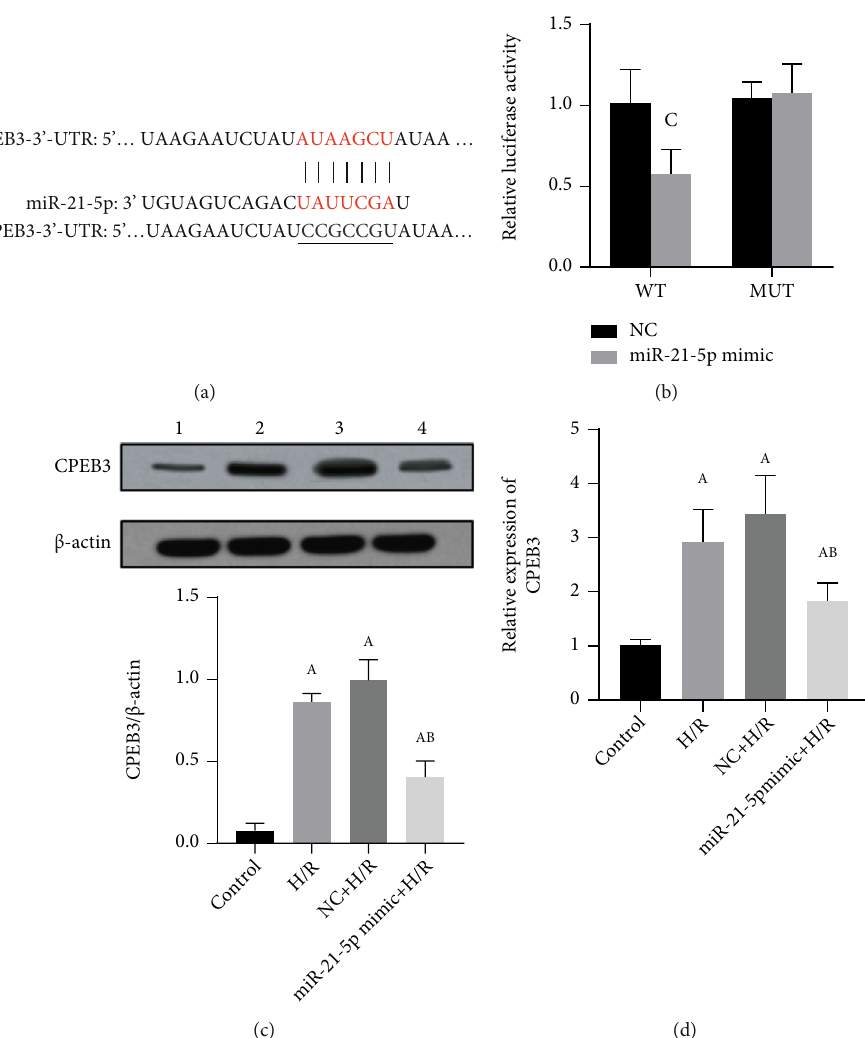
Figure 5: The veri fi cation of CPEB3 as a target of miR-21-5p ( n = 3 ). (a) CPEB3 as the target of miR-21-5p. (b) Luciferase reporter gene veri fi cation. (c) Protein expression level of CPEB3 when miR-21-5p was overexpressed in HT22 cells. (d) The expression level of CPEB3 mRNA when miR-21-5p was overexpressed in HT22 cells. The experimental groups are as follows: 1: control group; 2: H/R group; 3: NC+H/R group; 4: miR-21-5p mimic+H/R group. Note: Student ’ s t -test was used. Compared with the control group, a P < 0 : 05 ; compared with the H/R group, b P < 0 : 05 ; compared with the NC group, c P < 0 : 05